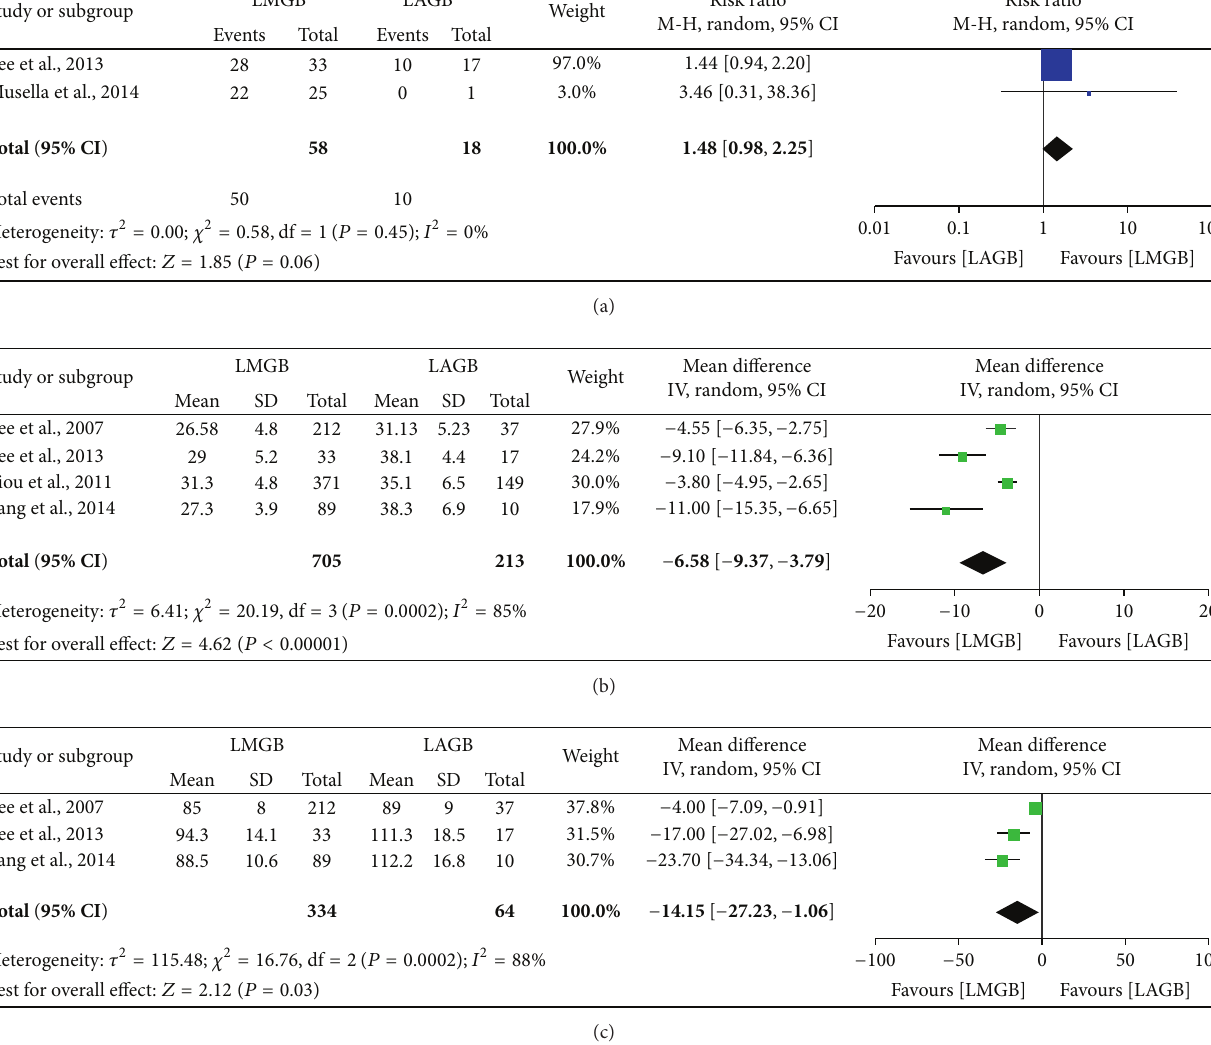
Figure 2: Meta-analysis comparing LMGB with LAGB. (a) Remission rate of T2DM. (b) Postoperative BMI. (c) Postoperative waist circumference. The estimates of the weighted risk ratio/mean difference in each study corresponded to the middle of each square and the horizontal line gave the 95% CI. The summary risk ratio/mean difference was represented by the middle of the solid